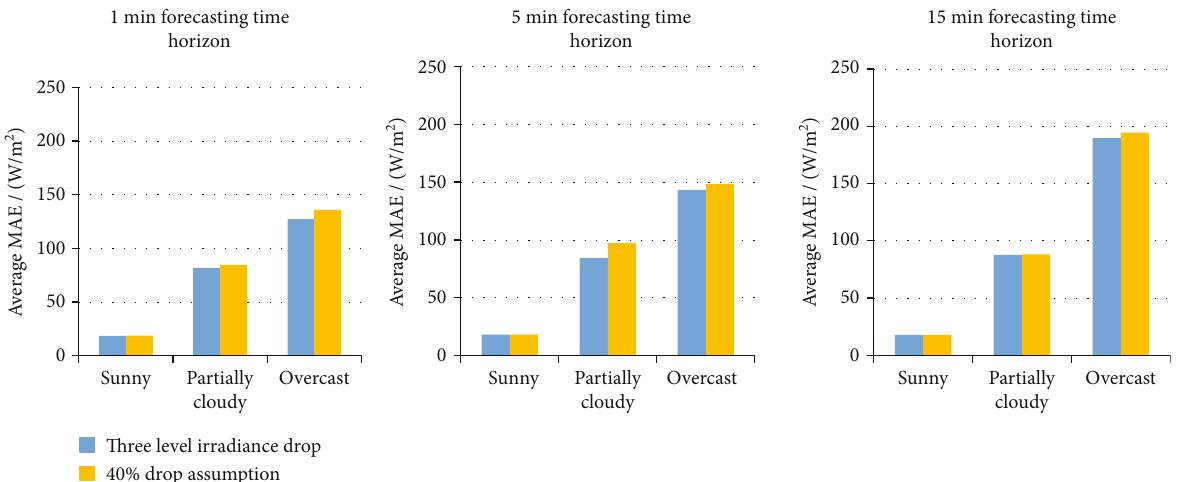
Figure 18: Comparison of MAEs obtained for the three-level cloud categorization and with a single drop level assumption (40%